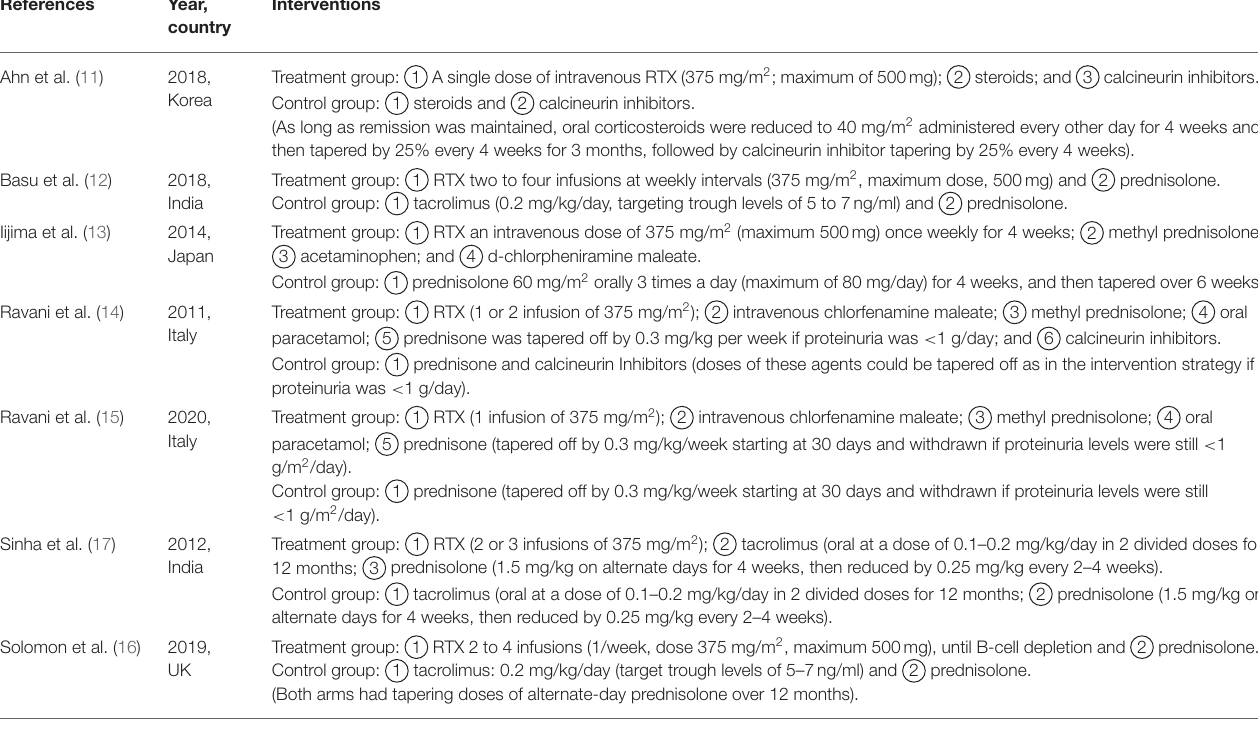
TABLE 2 | Interventions of studies included.